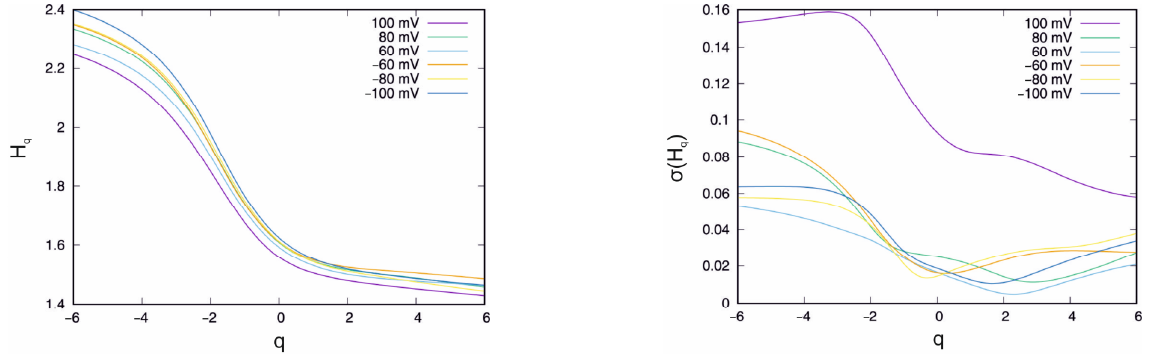
Figure 2. Mean value ( left ) and standard deviation ( right ) of the generalised Hurst exponent Hq.